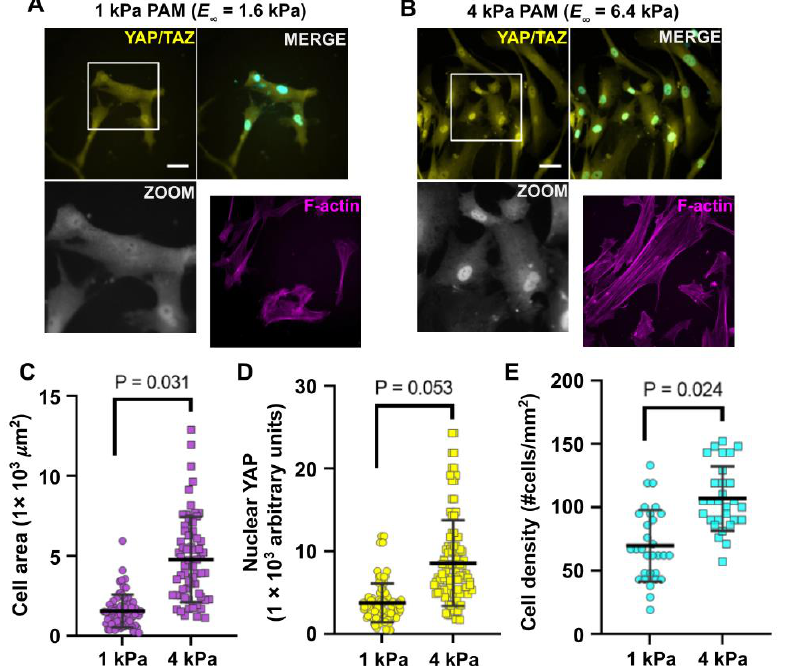
Figure 6. Mechanoresponse of human immortalized fibroblasts on elastic hydrogels with two different apparent stiffness. Human BJ fibroblasts were cultured for 48 h on 1 kPa (panel A ) and 4 kPa (Panel B ) polyacrylamide hydrogels functionalized with [100 µ g/mL] commercial collagen type I. Subcellular localization of Yes-associated protein (YAP)/TAZ (WW-domain-containing transcription regulator) proteins (yellow) were analyzed by immunofluorescence and epifluorescence microscopy DAPI (4', 6-diamidino-2-phenylindole dihydrochloride) (cyan) and Alexa488-coupled phalloidin (magenta) were used to stain nuclei and actin filaments (F-actin), respectively. Nuclear localization of YAP/TAZ proteins was highlighted in the zoom squares (gray). ( C ) Cell spreading (cell area) was quantified Figure 1. kPa and 4 kPa substrates. ( D ) Quantification of nuclear localization of YAP/TAZ proteins in fibroblasts cultured on 1 and 4 kPa substrates. Fluorescence intensity was presented in arbitrary units derived from the corrected total cell fluorescence (CTCF), see methods. ( E ) Cell density of fibroblasts cultured on 1 and 4 kPa substrates for 48 h. Data shows that for cells cultured on the stiffer condition there are more cells adhered on the substrates per unit area. Data shown are representative of 3 independent experiments (n = 3). In order to prove statistical differences, an unpaired t-test with Welch’s correction was performed. Bars presented in plots are mean ± standard deviation. Scale bar = 50 µ